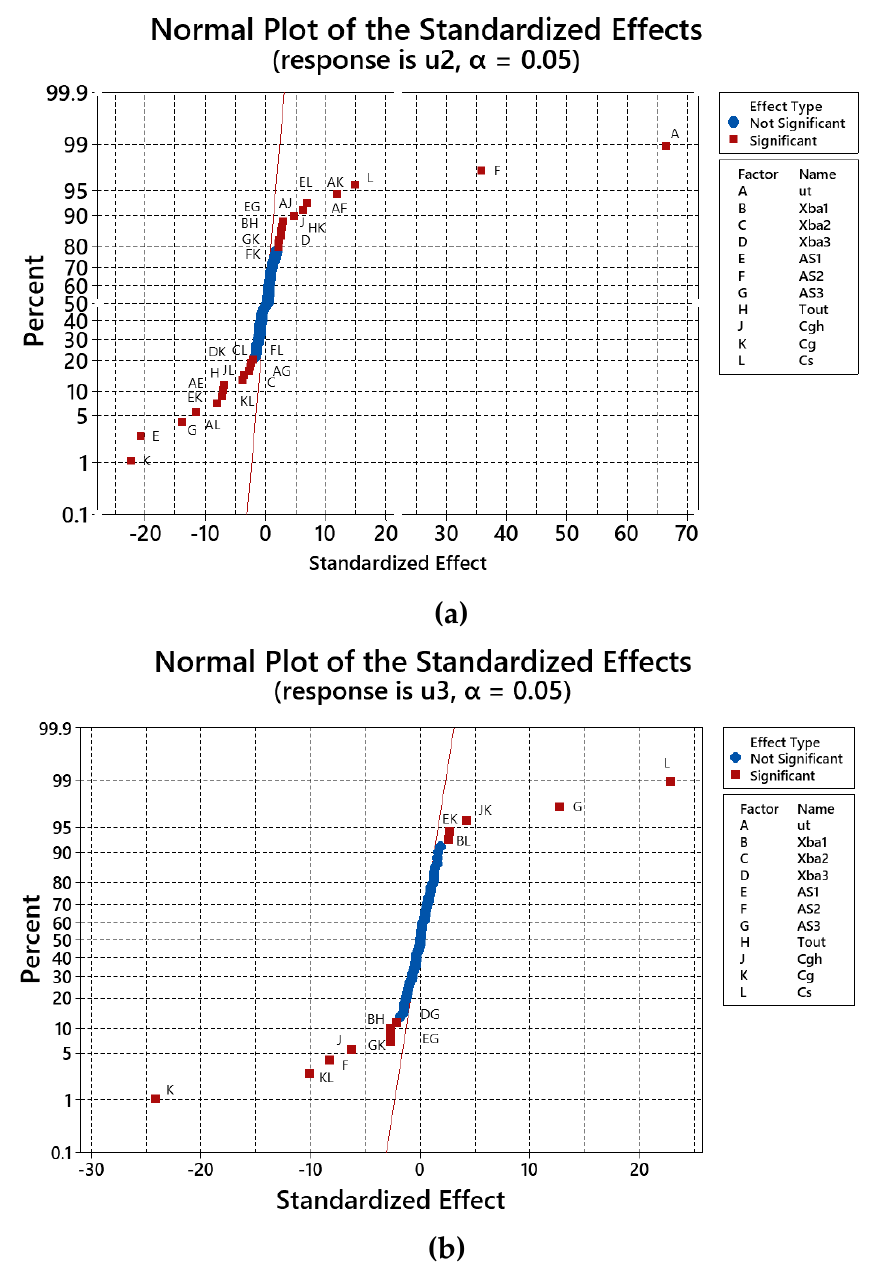
Figure 6. The evolution of response as a function of input parameters and their interactions ( a ) u 2 and ( b ) u